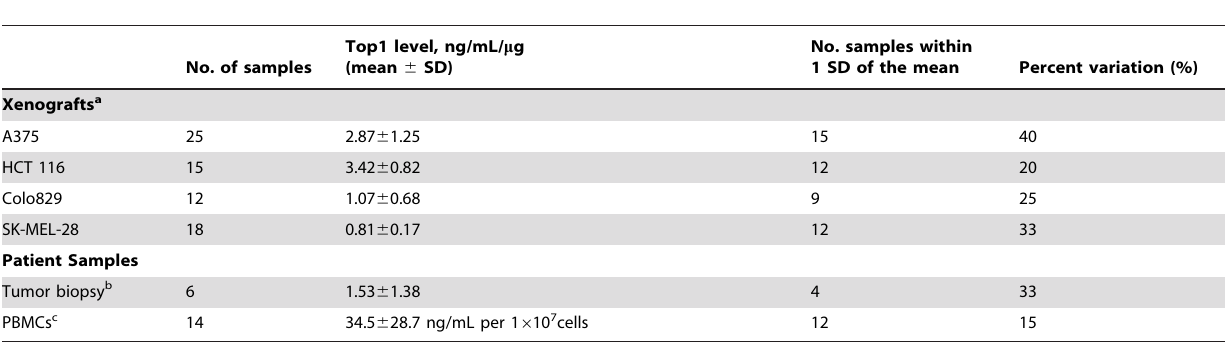
Table 5. Biological variation observed in baseline Top1 levels in xenograft models and patient samples.